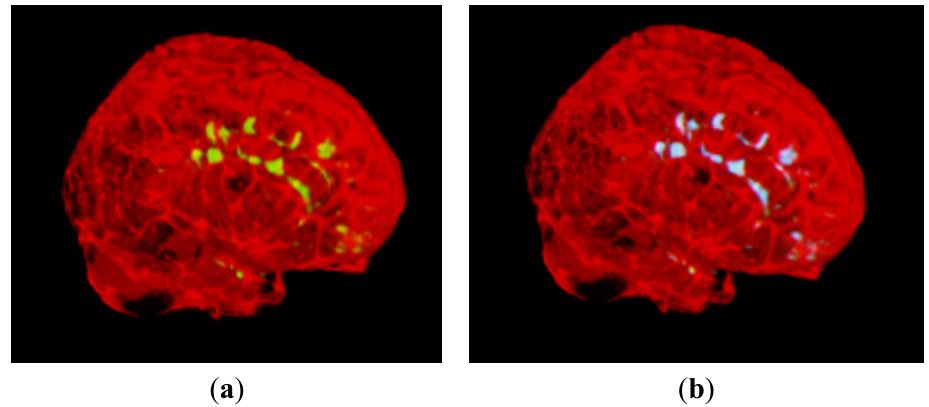
Figure 17. 3D visualization of the moderate MS lesion brain: brain ROI indicated by a transparent ruby color, ( a ) only the fuzzy labeled ground truth (light green), ( b ) the estimated fuzzy labels (light blue) derived from our method superimposed over the ground truth (light green) from similar view points. Notice how small features are generally well captured. Used code is provided by